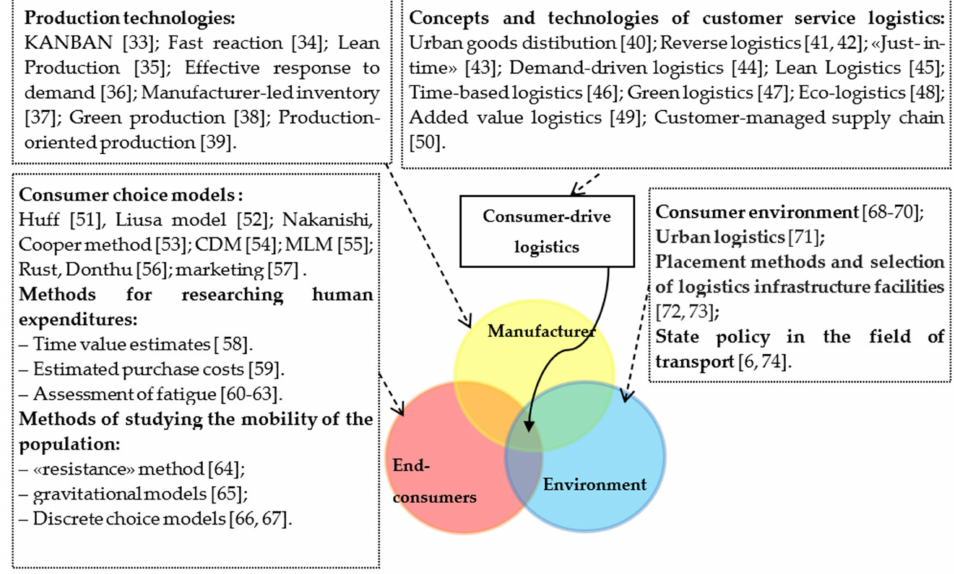
Figure 1. System Consumer driven-logistics for «Manufacturer»—«End consumers»—«Environment» system